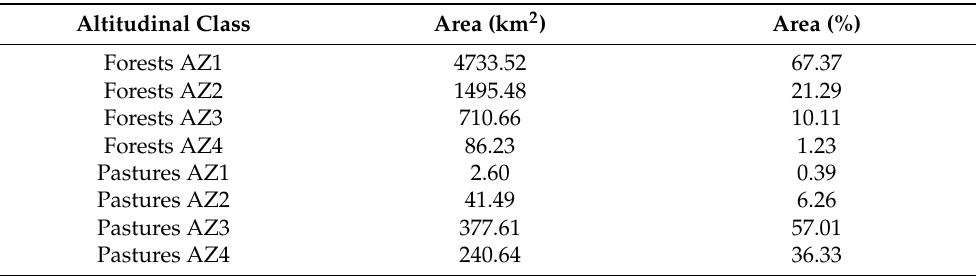
Table 6. Forests and Pastures CLC classes that did not change between 2001 and 2019, divided into the considered altitudinal zones.